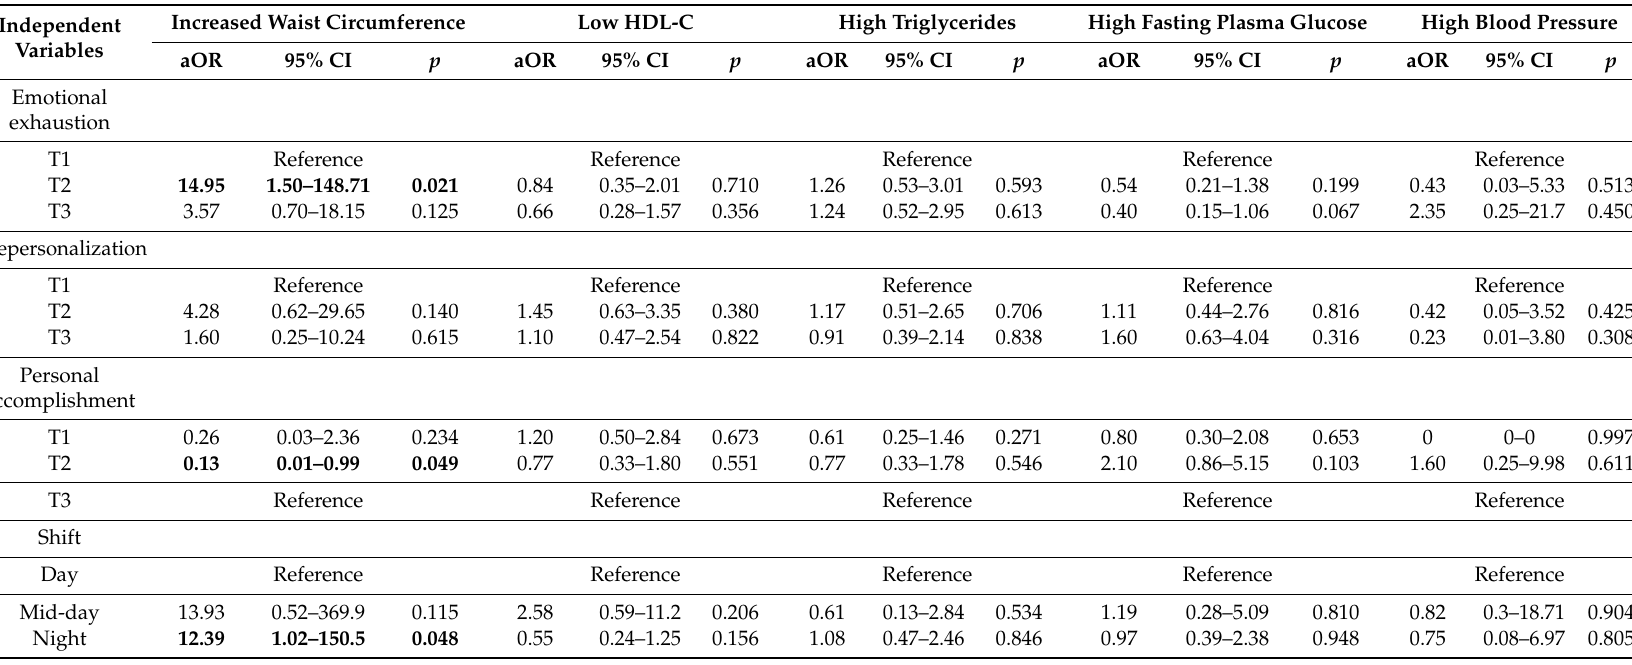
Table 2. Association of burnout domains with metabolic syndrome